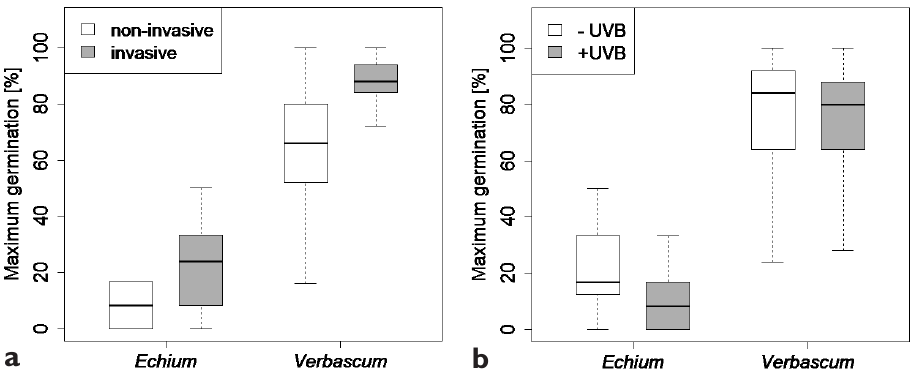
Figure 1. Maximum germination in the among-species approach testing for pre-adaptation of Echium and Verbascum seeds. a of invasive (grey) and non-invasive (white) species and b in response to UV-B radiation (grey) and no UV-B radiation (white)